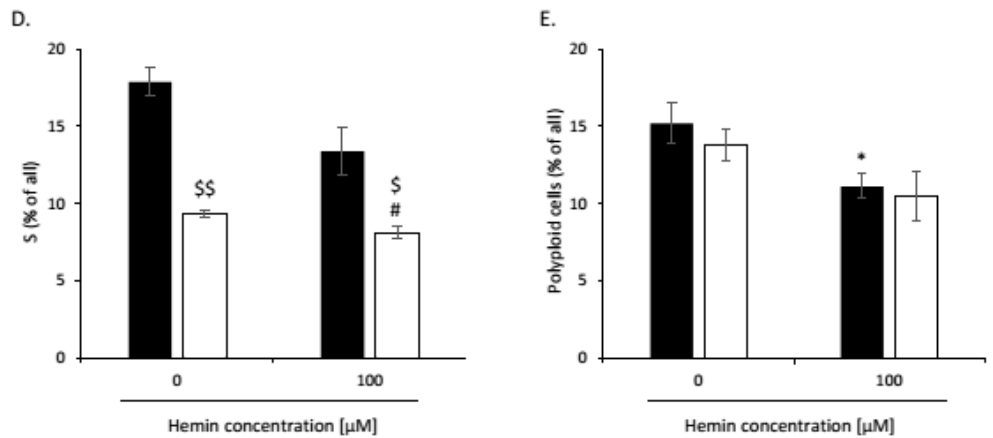
Figure A13. High hemin concentration correlates with an escape from senescence of hypoxic SW480 cells: changed accumulation in different phases of the cell cycle. Quantification of the percentage of cells in the subG1 ( A ), G0/G1 ( B ), G2/M ( C ), and S phases ( D ), and polyploid cells ( E ). Cell cycle analysis was performed with the Cell Cycle Analysis Kit (Sigma) and flow cytometry; Each bar represents mean ± SEM, n ≥ 3; * p < 0.05—vs. control normoxia; # p < 0.05, ### p < 0.001—vs. control hypoxia; $ p < 0.05, $$ p < 0.01—normoxia vs. hypoxia.